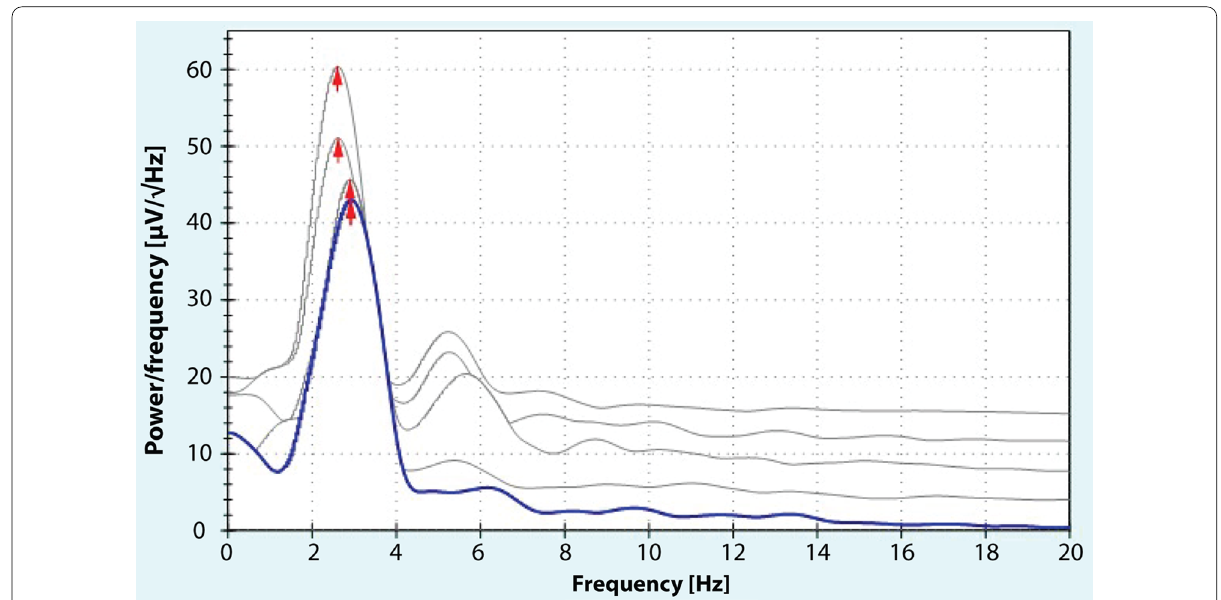
Fig. 1 Tremor analysis using surface accelerometers attached to the paravertebral muscles (at thoracic level 12 on the right) revealed high‑amplitude rhythmic oscillations with a peak frequency of 2–4